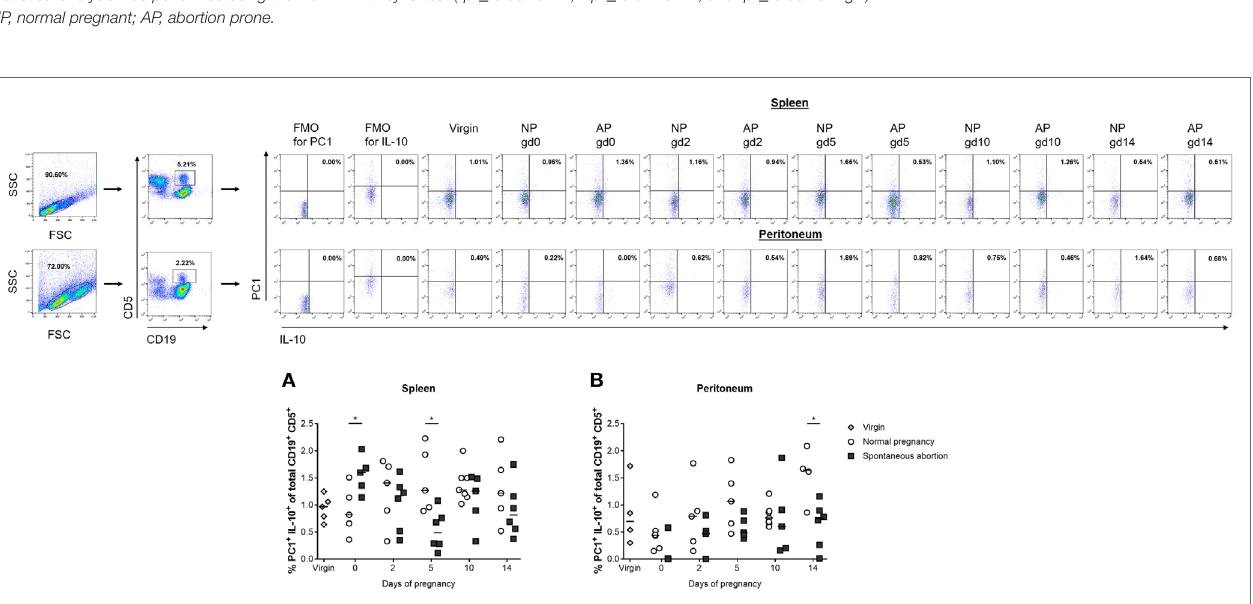
FigUre 2 | The frequencies of peritoneal CD19 + CD5 + PC1 + IL-10 + B cells were significantly reduced in abortion-prone (AP) females on gestation day (gd) 14. Virgin ( n = 4–5 per organ) as well as normal pregnant (NP, n = 4–7 per organ) and AP females ( n = 5–6 per organ) were analyzed at gd0, 2, 5, 10, and 14 for the frequencies of PC1 + IL-10 + cells within the CD19 + CD5 + B1a B cell population in spleen (a) and peritoneum (B) . Flow cytometry gating strategy and